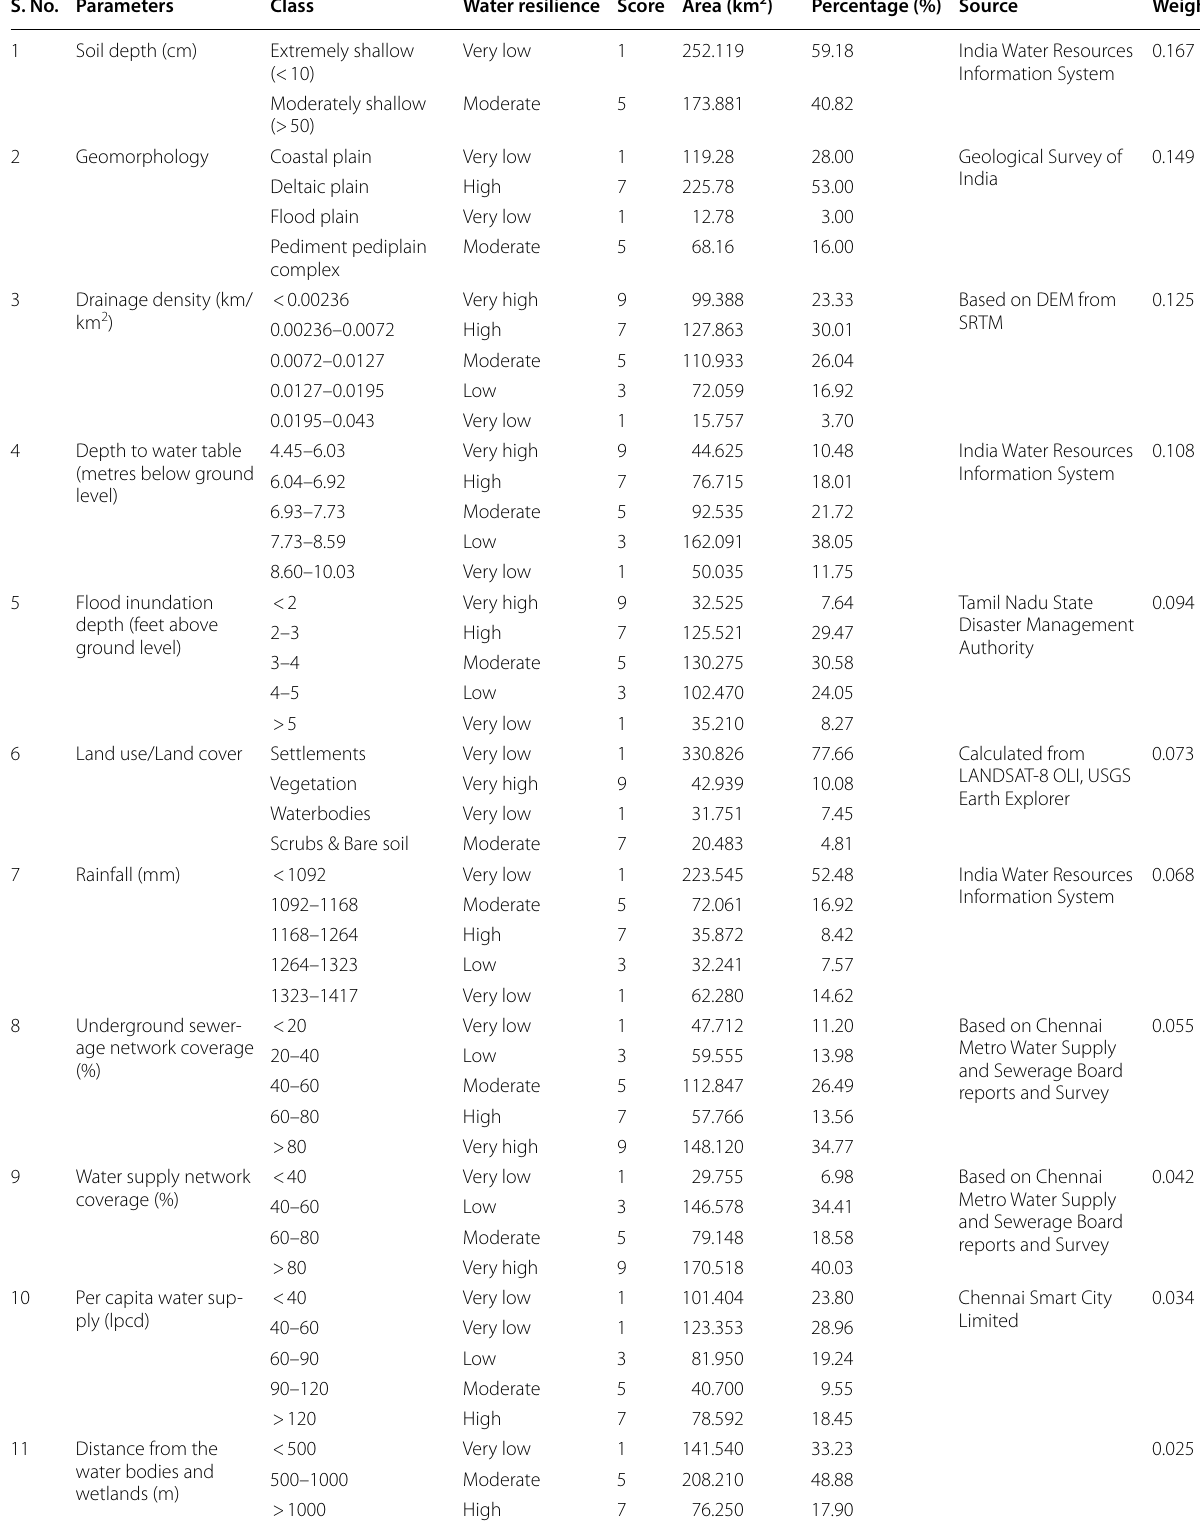
Table 3 Water resilience determining parameters and their sub-classes with area and weights S. No. Parameters